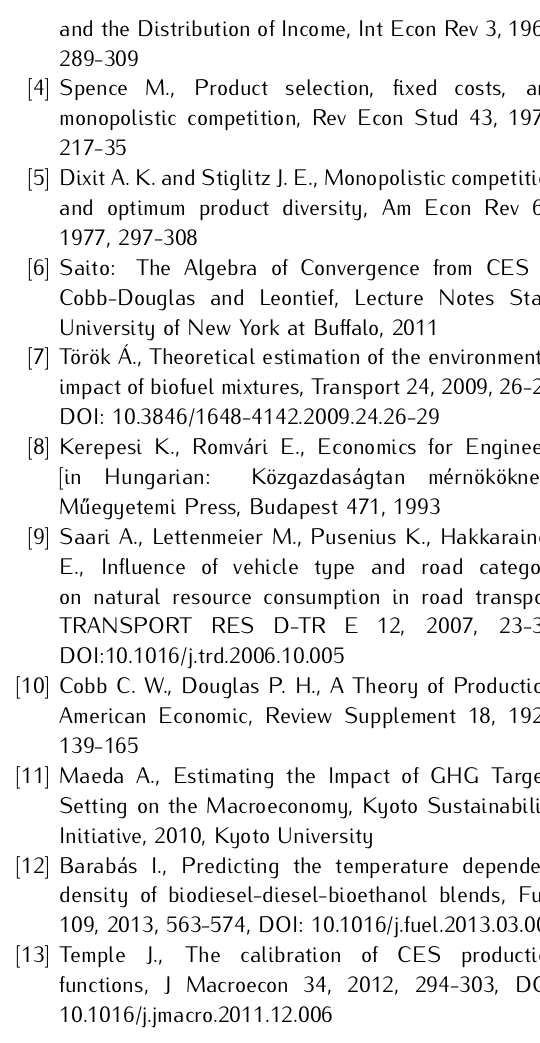
Figure 2. Investigation of fossil fuel consumption based on production function in 2010 (source: own